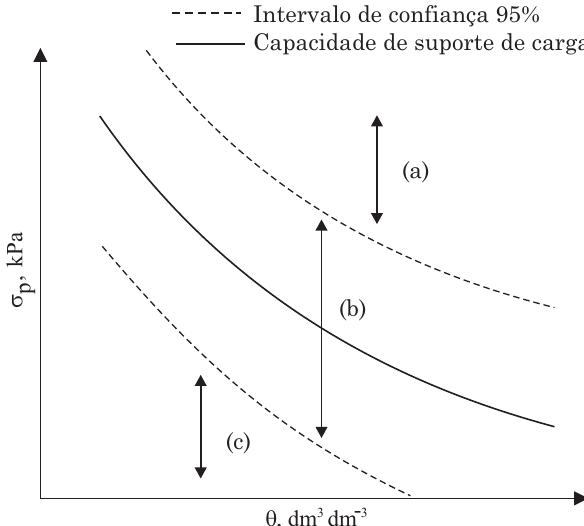
Figura 1. Modelo de capacidade de suporte de carga do solo, com as três “regiões” de análise da compactação. Região “a”: com compactação; “b”: sem compactação, mas com tendência a compactar; e “c”: sem compactação. Modificado de Dias Júnior et al.